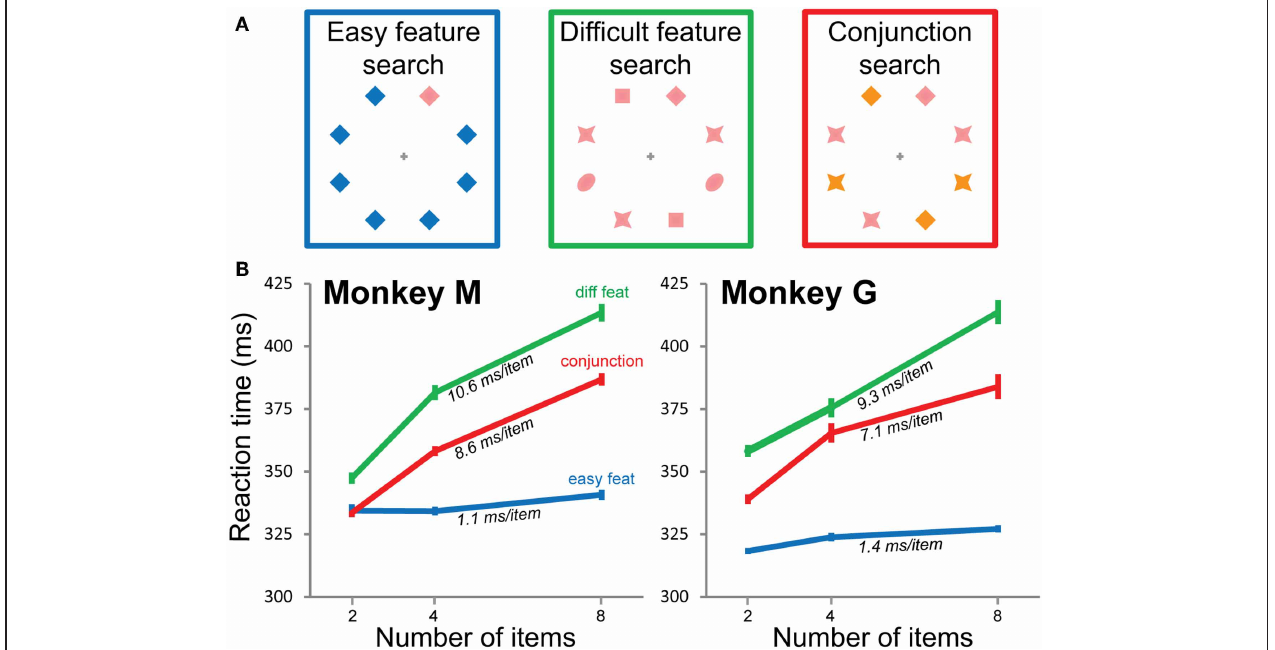
FIGURE 2 | Visual search conditions and mean reaction times. (A) Three search conditions. The target is always the pink diamond, that can be presented along blue diamonds (easy feature search, blue, left), other pink objects (difficult feature search, green, middle), or other combinations of pink/orange and diamond/star (conjunction search, red, right). (B) Mean